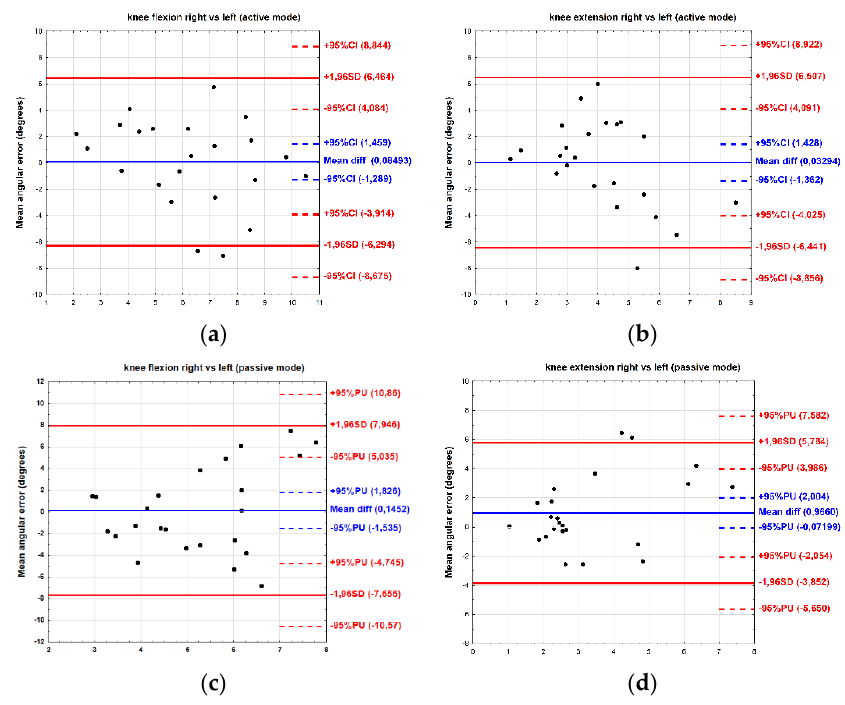
Figure 4. Bland–Altman plot showing agreement between right and left sides for active ( a , b ) and passive ( c , d ) modes of joint position sense (JPS).